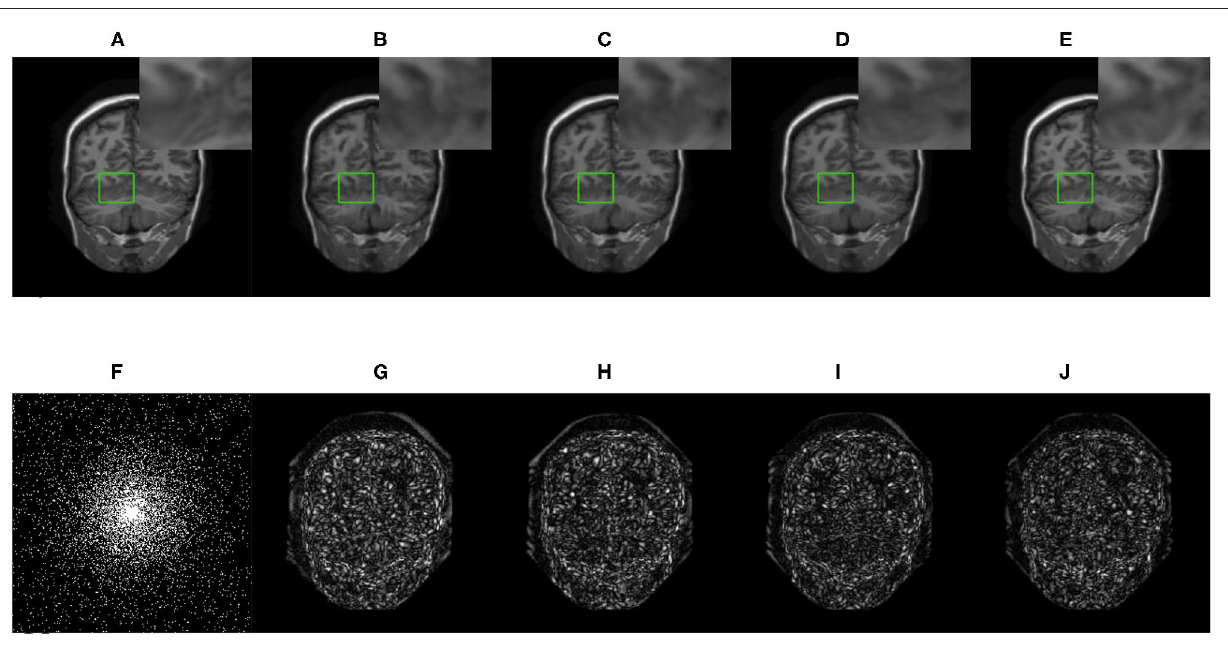
FIGURE 6 | The reconstructed MRI for the 10-fold accelerated k-space data masked with the 2D Gaussian distribution by using different GAN-based methods. (A) Fully-sampled MRI, (B) DAGAN, (C) DAWGAN, (D) DAWGAN-GP, (E) SARA-GAN, (F) 2D mask, (G) DAGAN(error), (H) DAWGAN(error), (I) DAWGAN-GP(error), and (J)